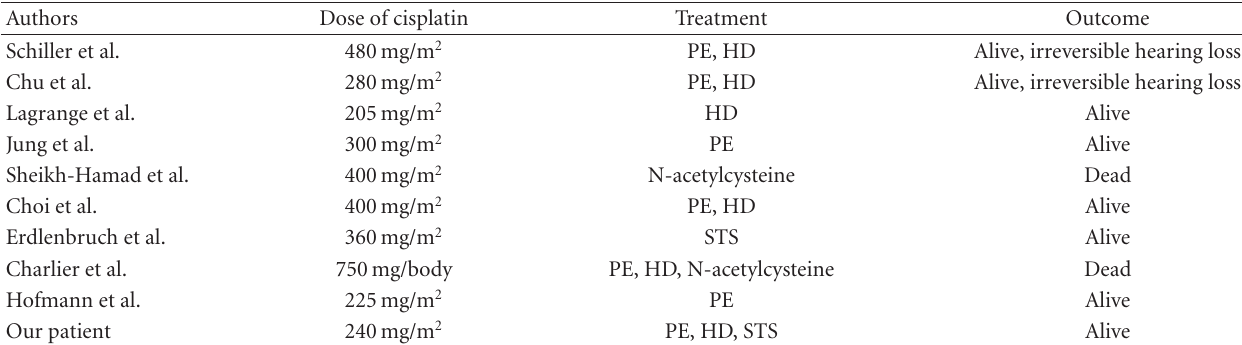
Table 1: Selected literature of cisplatin overdose; PE: plasma exchange; HD: hemodialysis. STS: sodium thiosulfate. Authors Dose of cisplatin Treatment